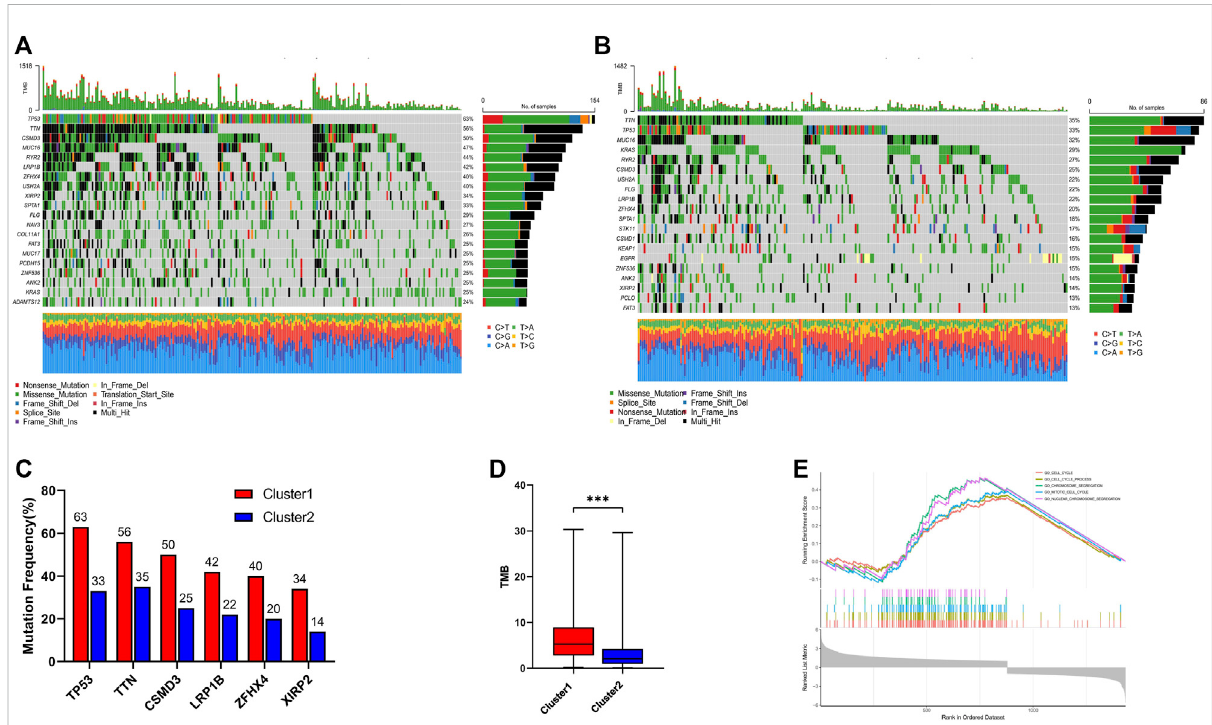
FIGURE 4 Genomic alterations and Gene set enrichment analysis between cluster 1 and cluster 2. (A) Landscape of mutation pro fi les in cluster 1; (B) Landscape of mutation pro fi les in cluster 2; (C) The six genes with the greatest variation in mutation frequency between cluster 1 and cluster 2; (D) The difference oftumor mutation burden betweencluster1 andcluster 2; (E) Top fi vemostsigni fi cantalteredKEGG pathways incluster 1compared with cluster 2. *** means p <